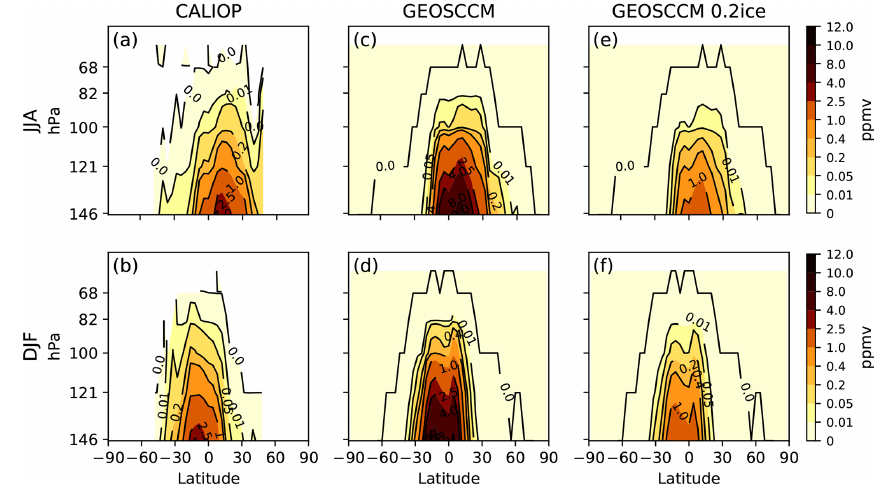
Figure 3. Zonal mean convective IWC (ppmv) from CALIOP and GEOSCCM above 146hPa. The CALIOP ice data are averaged over JJA (a, c, e) and DJF (b, d, f) from May 2008 to December 2013. For CALIOP data (a, b) , we show the ice from all clouds minus the ice from cirrus clouds, which is a rough estimate of convective ice in the TTL region. For GEOSCCM ice, we show convective ice (c, d) . To better match the tropical average CALIOP ice field above 120hPa, we decrease the GEOSCCM ice by 80% (0.2ice) and show the GEOSCCM 0.2ice in panels (e) and (f) . Note that we use a nonlinear color scale.